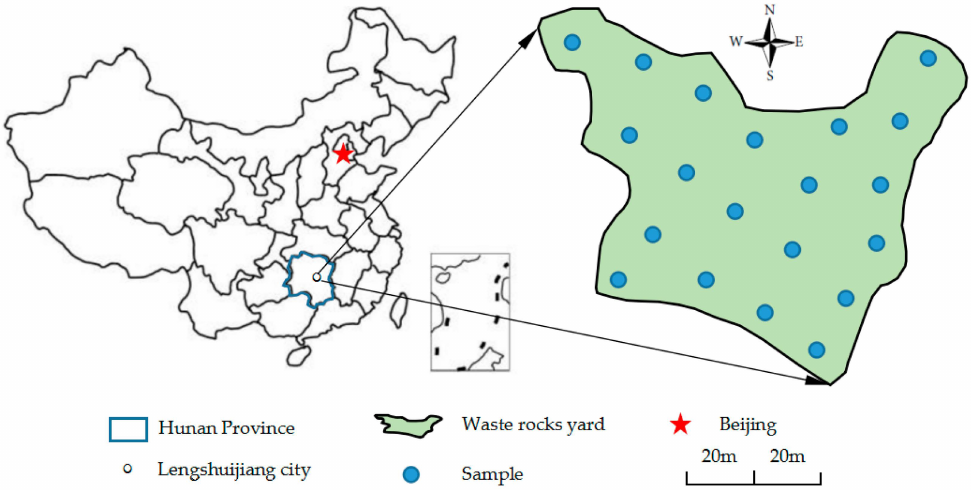
Figure 1. Map showing location of sampling